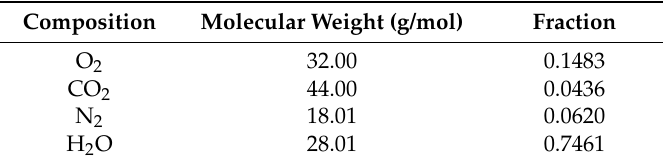
Table 2. The composition of the exhaust gas.